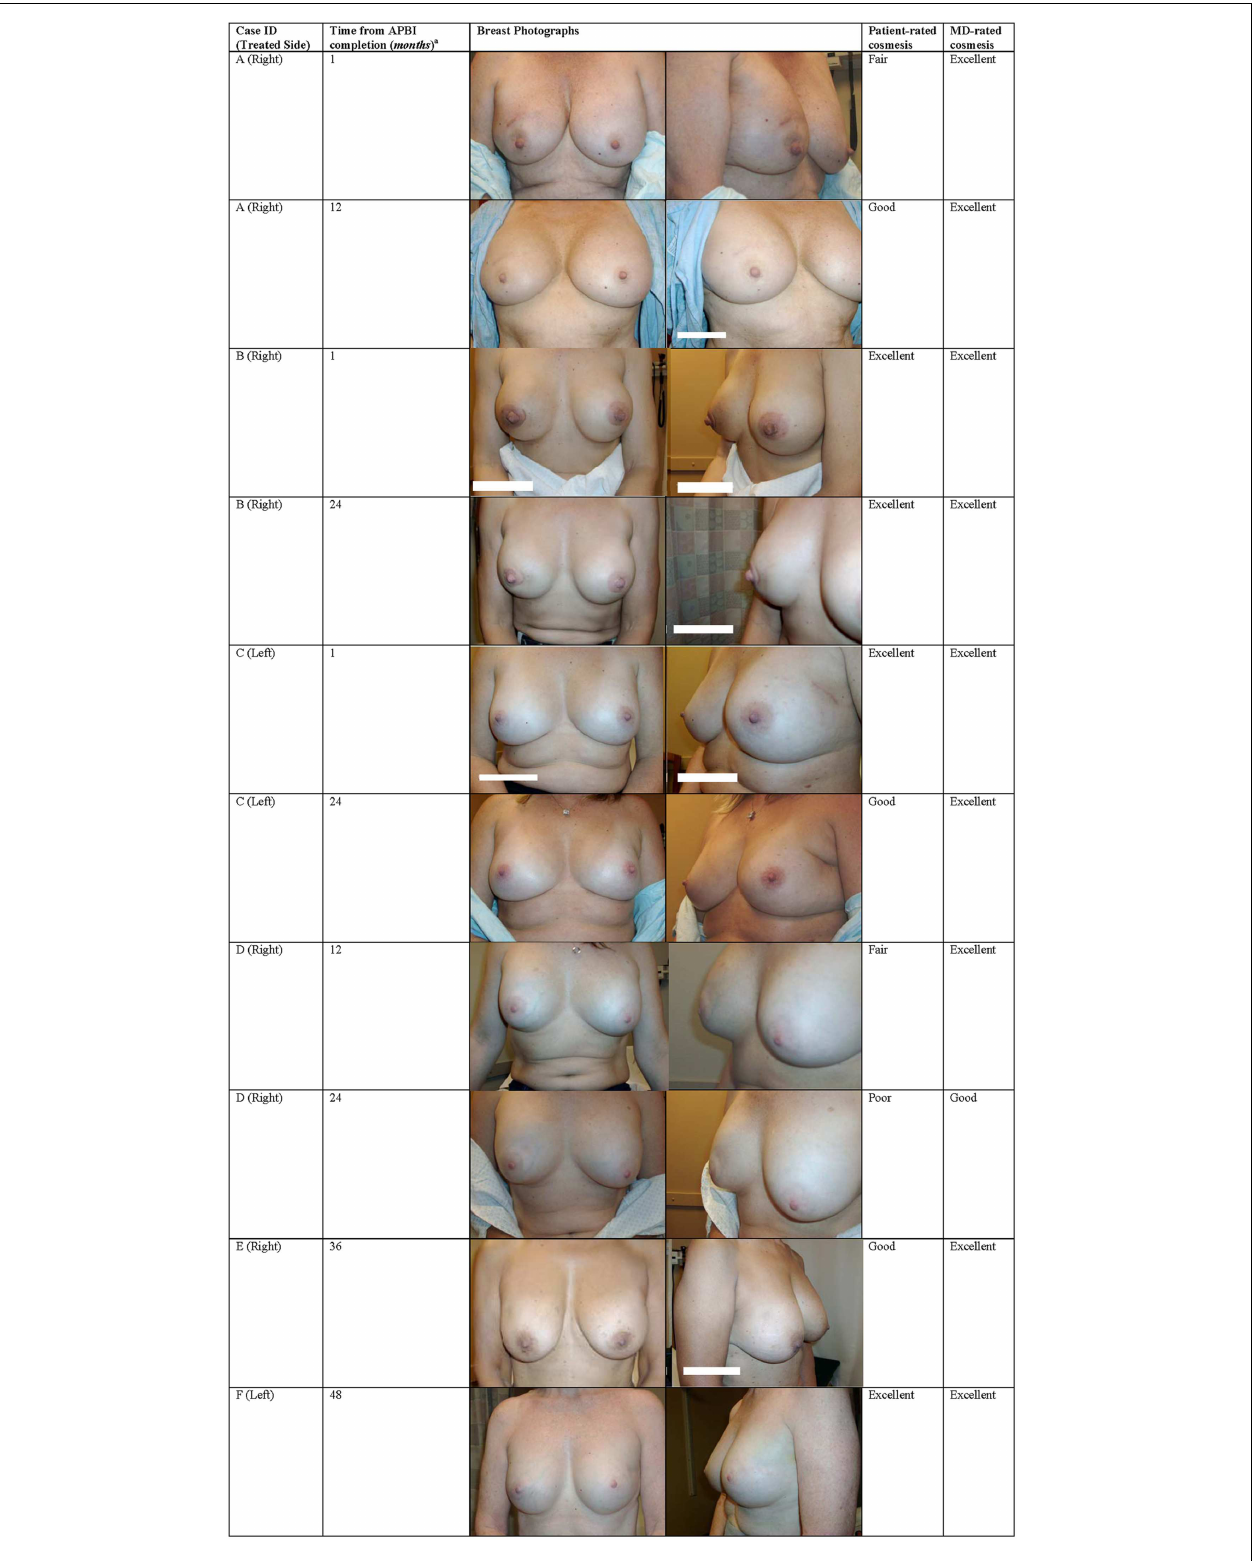
FIGURE 3 | Breast photographs and cosmesis after EB-APBI. a Time fromAPBI completion > 1month designated as the closest 6months follow-up time point.